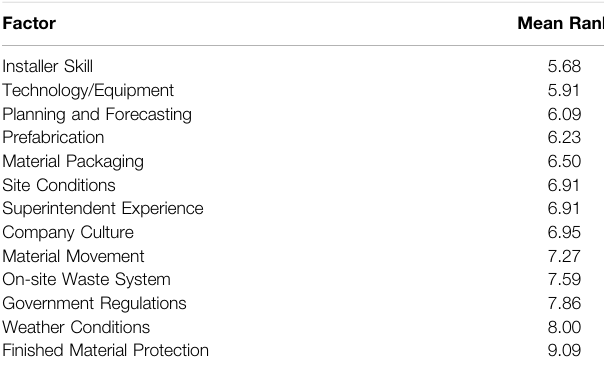
TABLE 10 | Mean ranks of the factors: responses of the participants with a high school diploma. Factor Mean Rank Installer